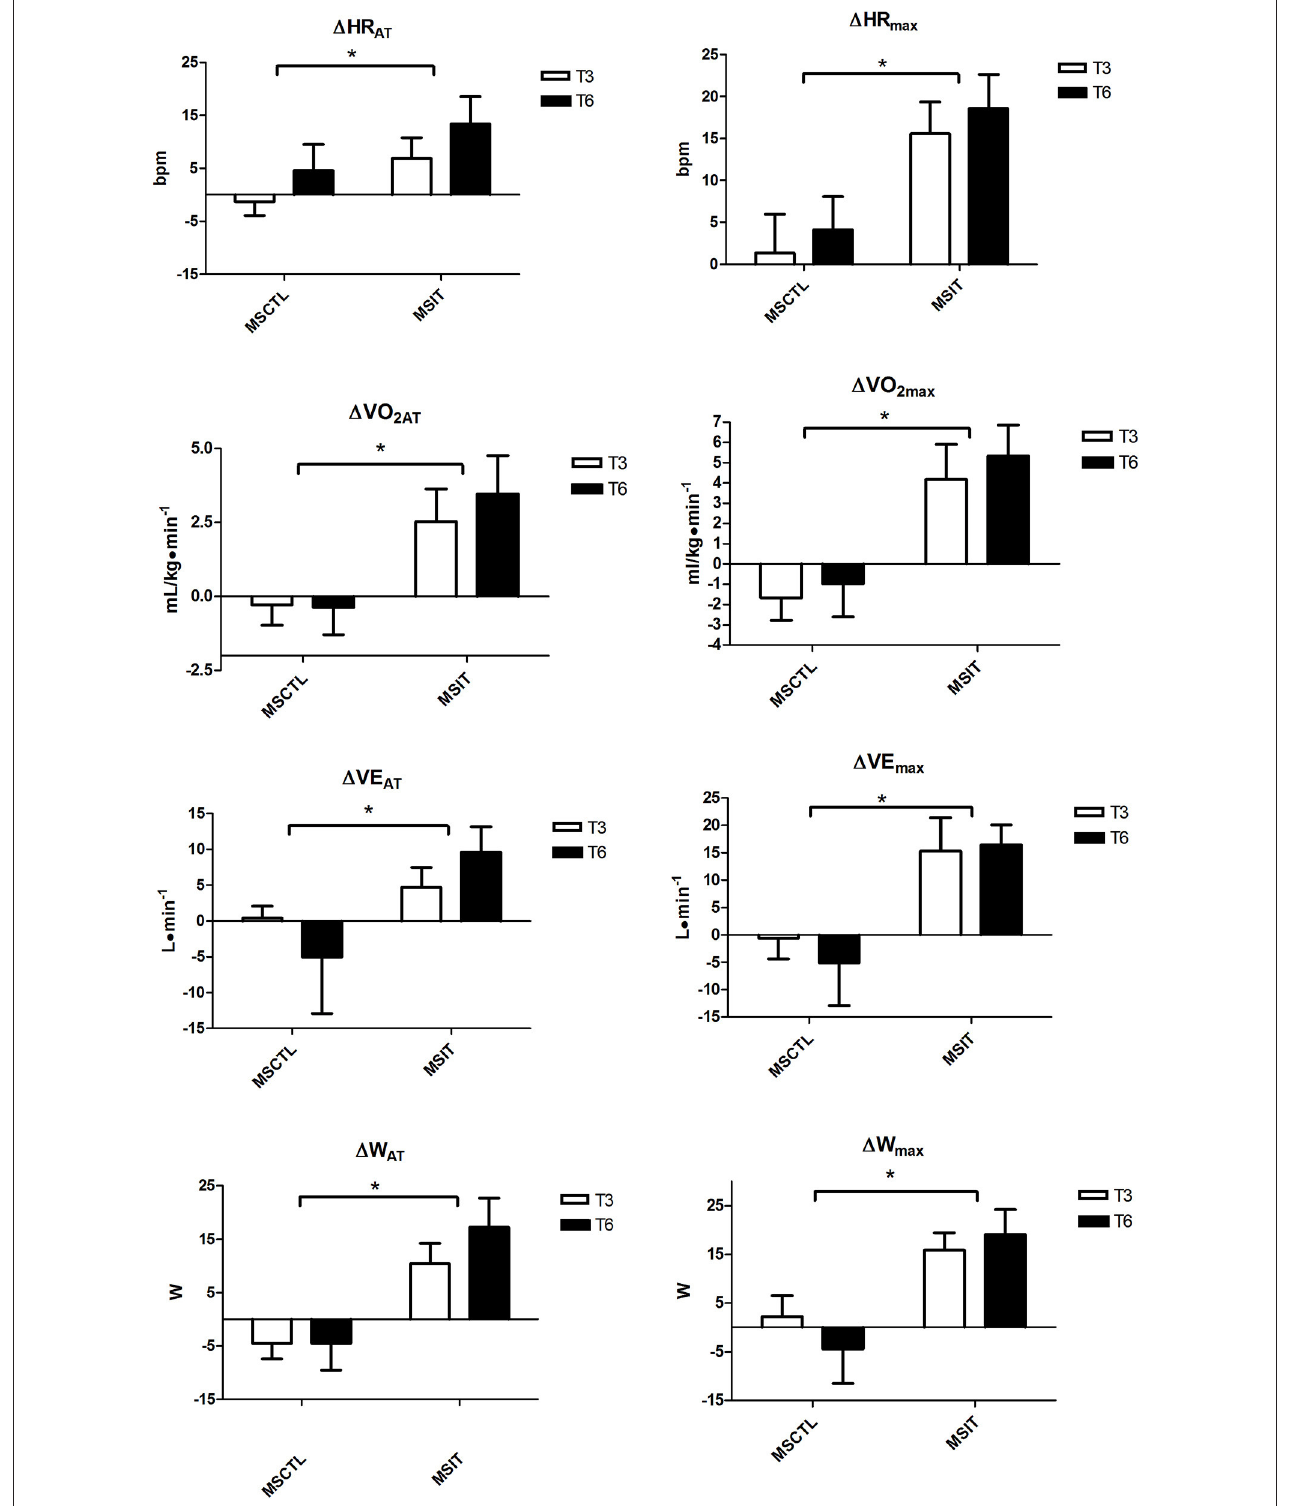
FIGURE 1 | Variation with respect to T0 in CPT parameters collected at T3 and T6. Brackets denote a significant group effect, * p < 0.05 between groups. Values are mean ± SD .